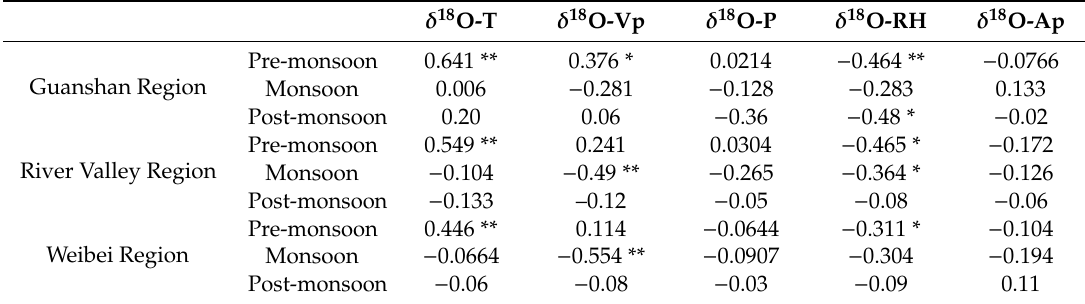
Table 2. Statistical correlations between daily precipitation δ 18 O and local meteorological parameters at Guanshan, River Valley and Weibei during the di ff erent